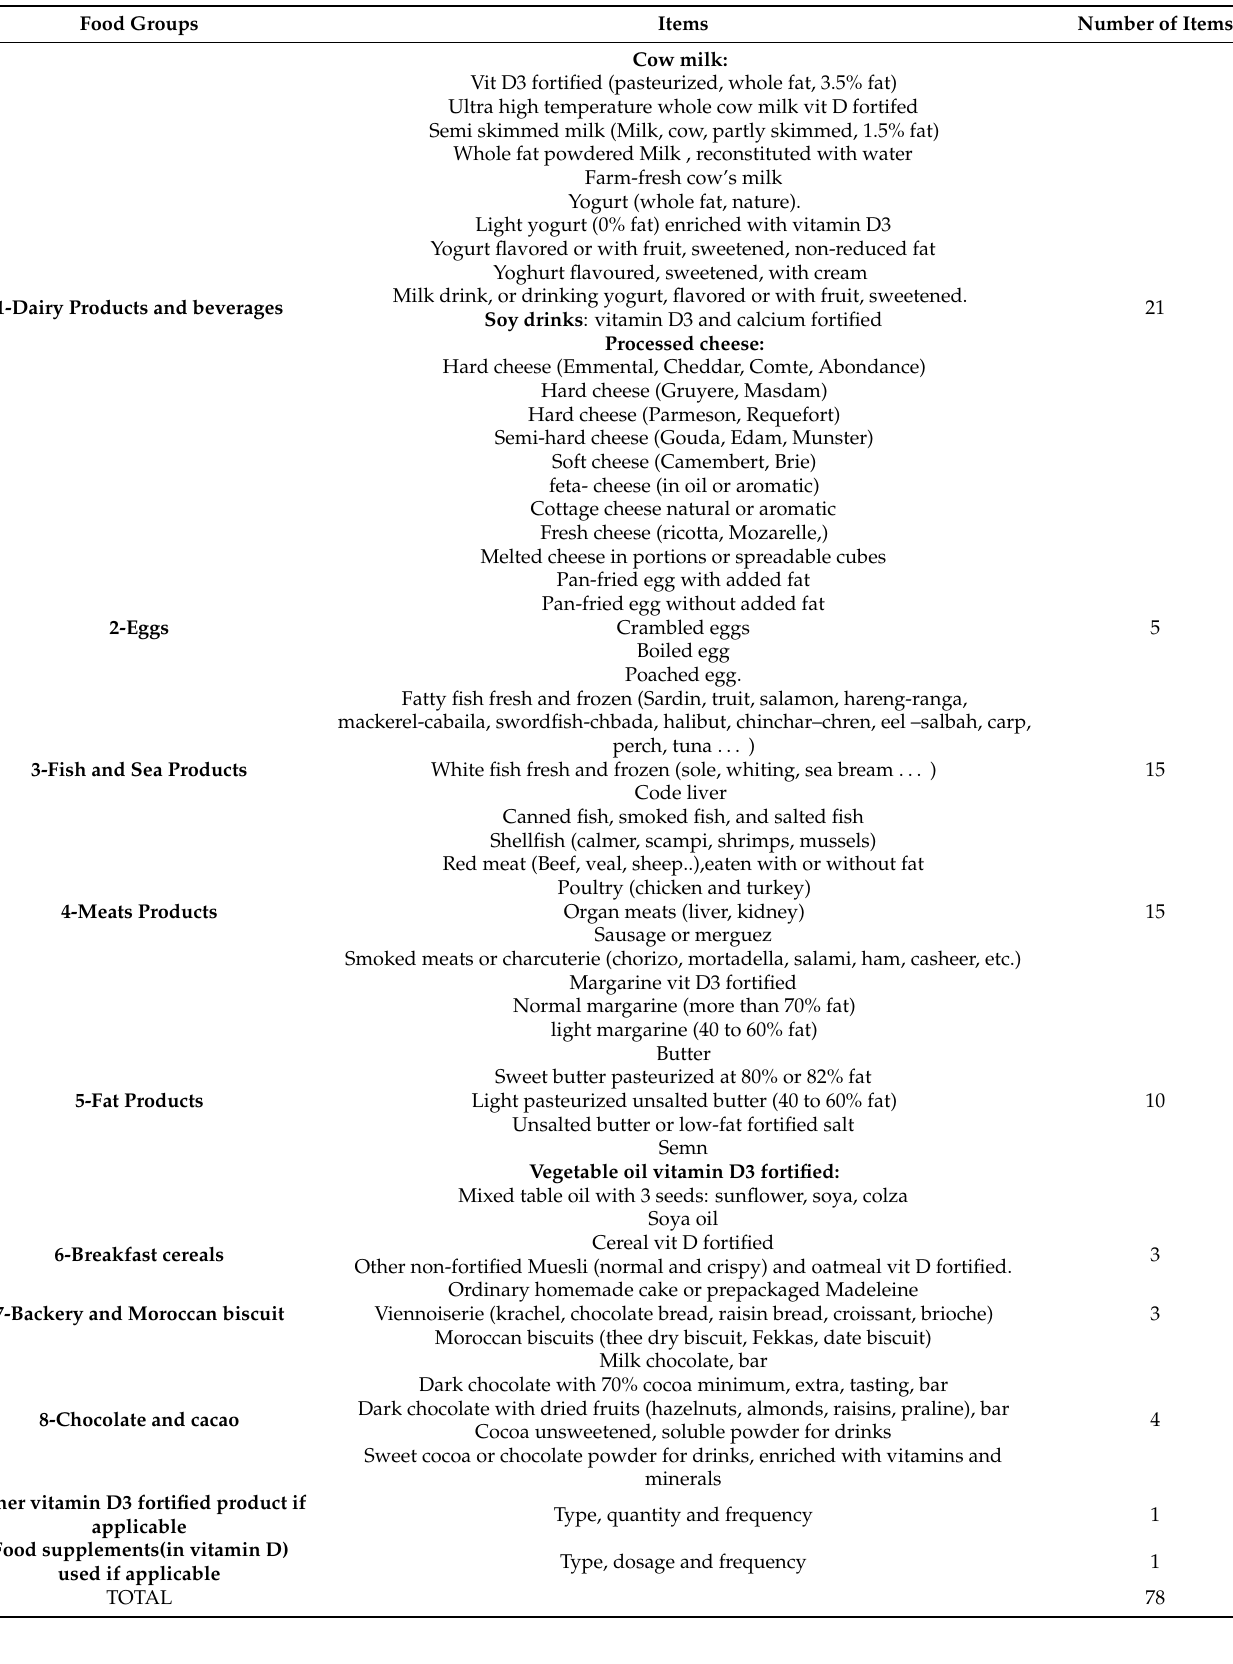
Table 1. Number of items selected for the